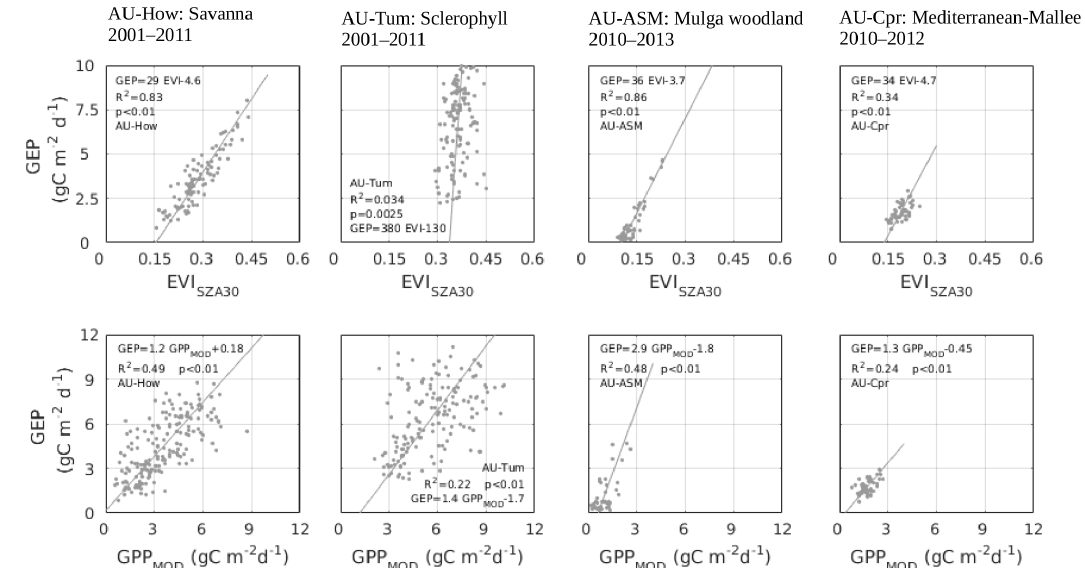
Figure 5. Top row: linear regression between 16- and 8-day time series of measured gross ecosystem productivity (GEP; gCm − 2 d − 1 ) (top row) and the MODIS fixed solar zenith angle of 30 ◦ enhanced vegetation index (EVI SZA30 ) at (a) Howard Springs (AU-How) open woodland savanna, (b) Alice Springs mulga (AU-ASM), (c) Tumbarumba (AU-Tum) wet sclerophyll forest eddy, and (d) Chowilla mallee (AU-Cpr) covariance site. Lower row: regression between GEP and MODIS gross primary productivity (GPP MOD ) (e) AU-How, (f) AU-Tum, (g) AU-ASM, and (h)